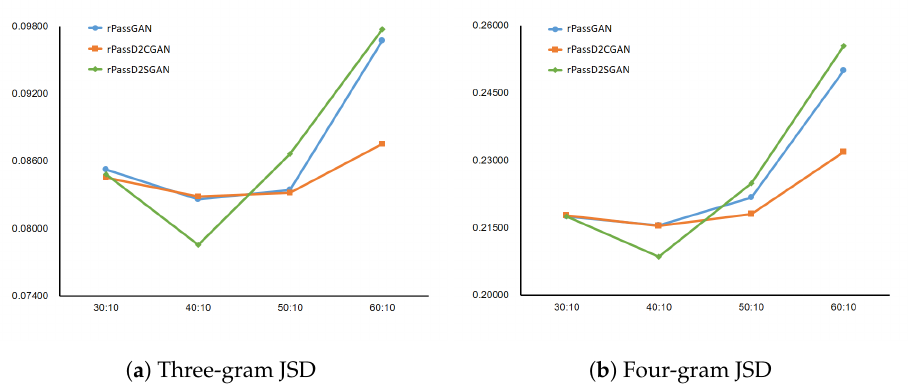
Figure 6. N-gram JSD (N = 3, 4) by G/D ratio ( X -axis: G/D training ratio; Y -axis: JSD value). The data applied in training consisted of a RockYou password dictionary of length